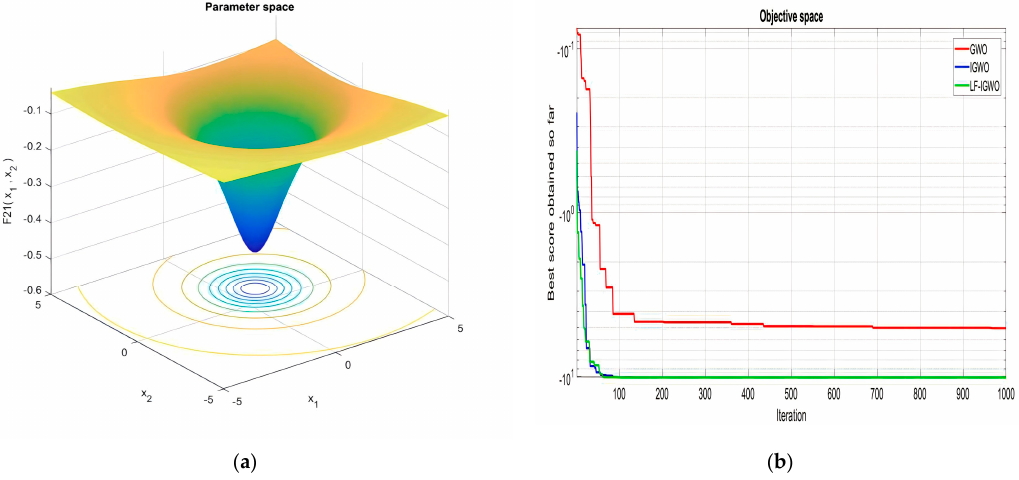
Figure 22. ( a ) Search space for fixed dimensional function F20 ( b ) Comparison of convergence curve for F20.